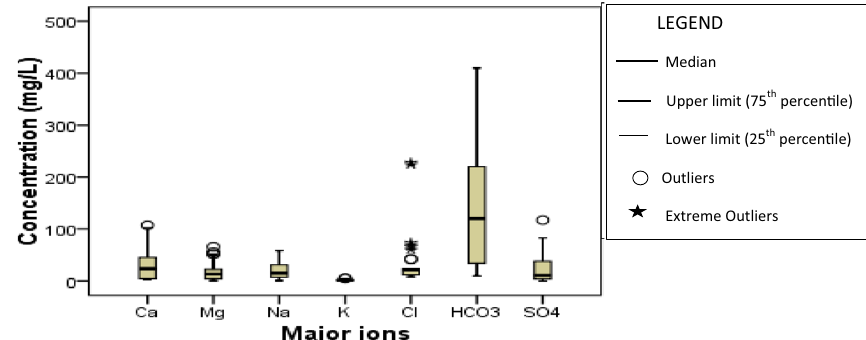
Fig. 4 Boxplot of major ions in groundwater within the Asutifi- North district